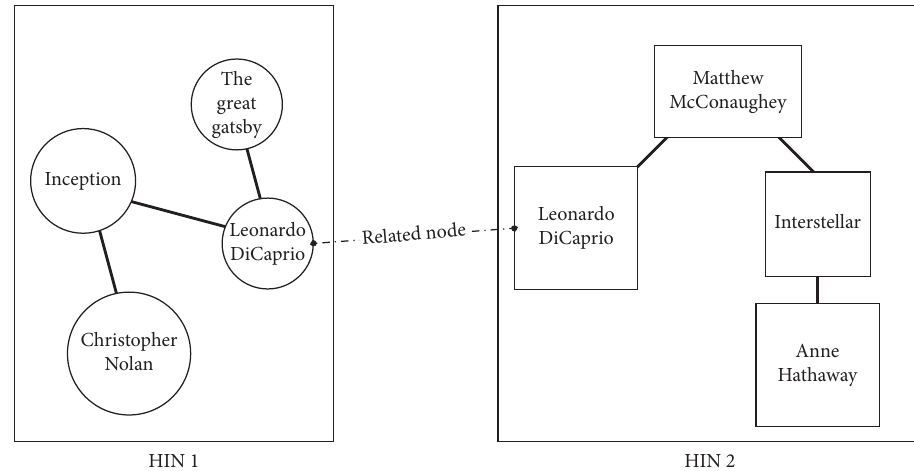
Figure 1: General situation of multi-HIN